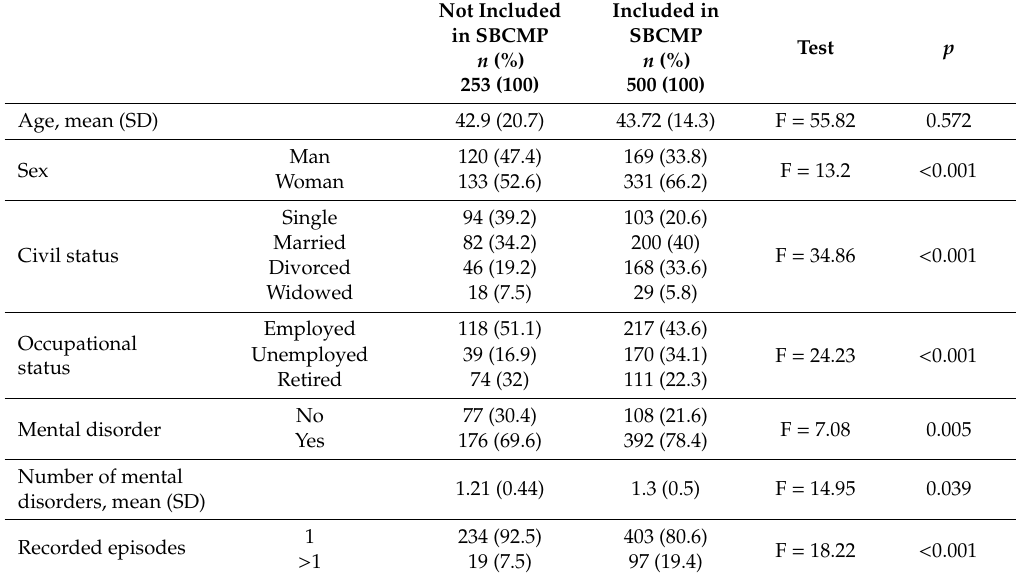
Table 4. Sociodemographic and clinical characteristics according to inclusion in the Suicidal Behaviour Case Management Programme